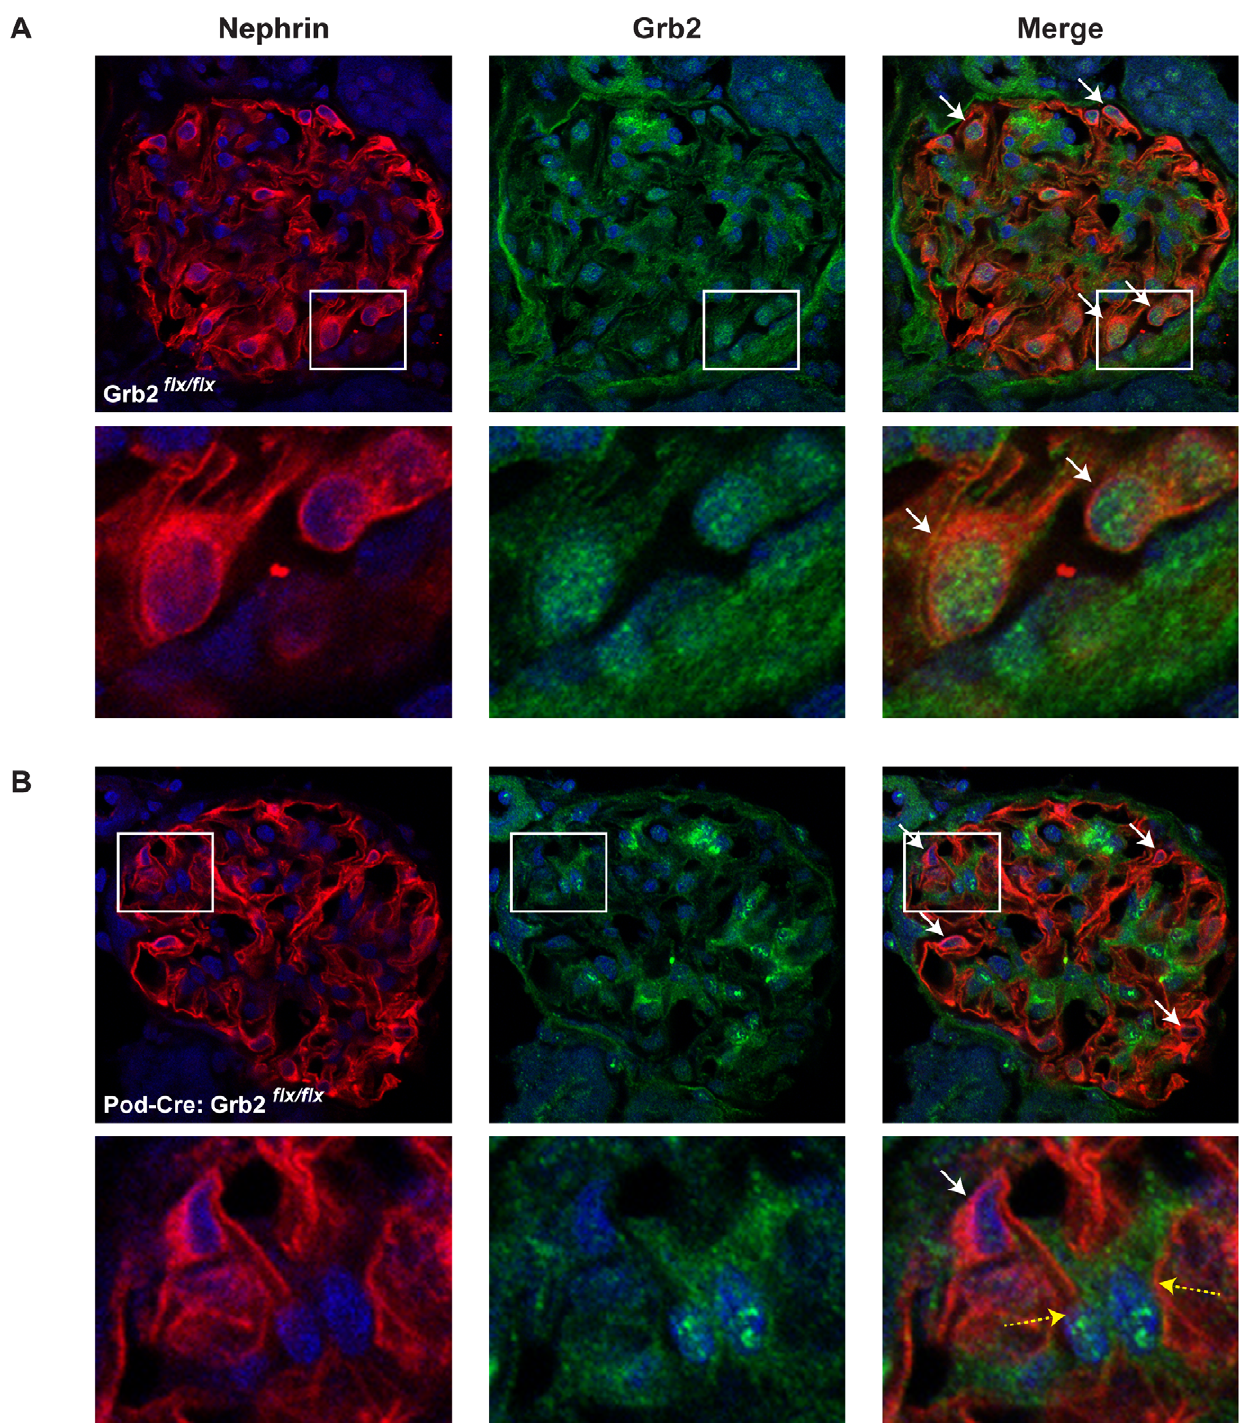
Figure 1. Grb2 is expressed in wild-type mouse podocytes. Immunofluorescent staining for Nephrin and Grb2 in a wild-type (A, Grb2 flx/flx ) or mutant (B, Podocin -Cre; Grb2 flx/flx ) glomerulus. Arrows indicate nephrin-expressing podocyte cells located at the periphery of the glomerular tuft. Framed areas from top panels are shown at a higher magnification below. Grb2 staining is absent from Podocin -Cre; Grb2 flx/flx podocytes. Dashed yellow arrows in B show nephrin-negative non-podocyte cells that retained Grb2 expression. suggested that Grb2 is important for the regulation of actin In the mouse genome, two Grb2-related adaptor proteins, dynamics in podocytes, our data unexpectedly but clearly show namely Grap1 (Grap) and Grap2 (Gads), are present and may that its function is not essential in vivo . have compensated for the inactivation of the Grb2 locus, thus